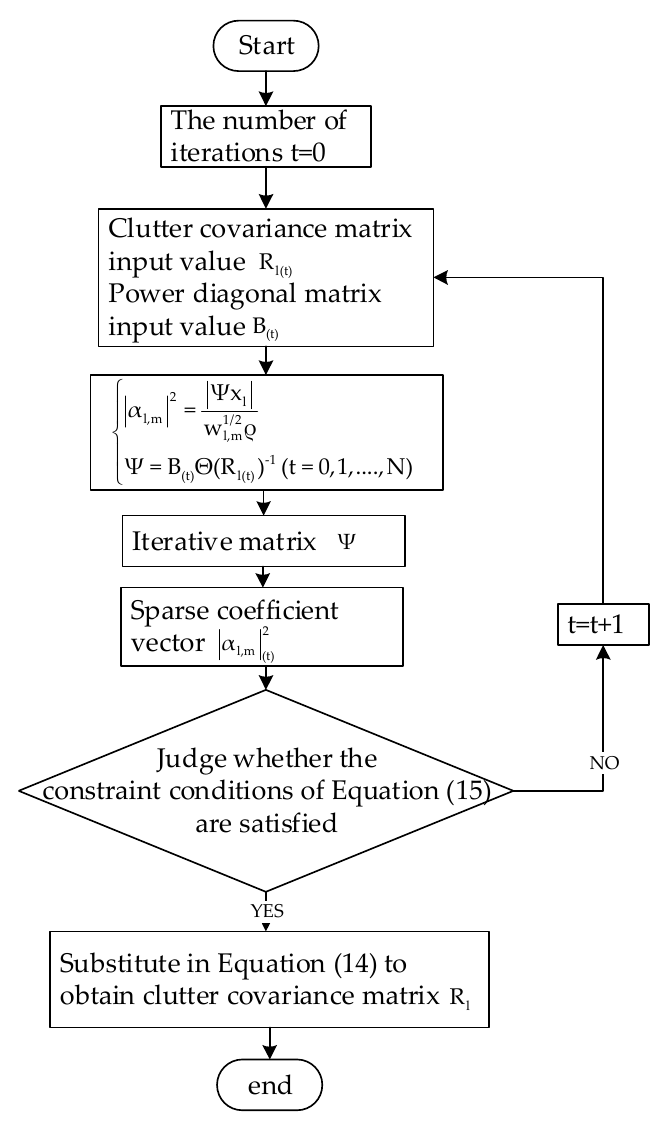
Figure 3. Flow diagram of clutter covariance matrix estimation based on SPICE algorithm.